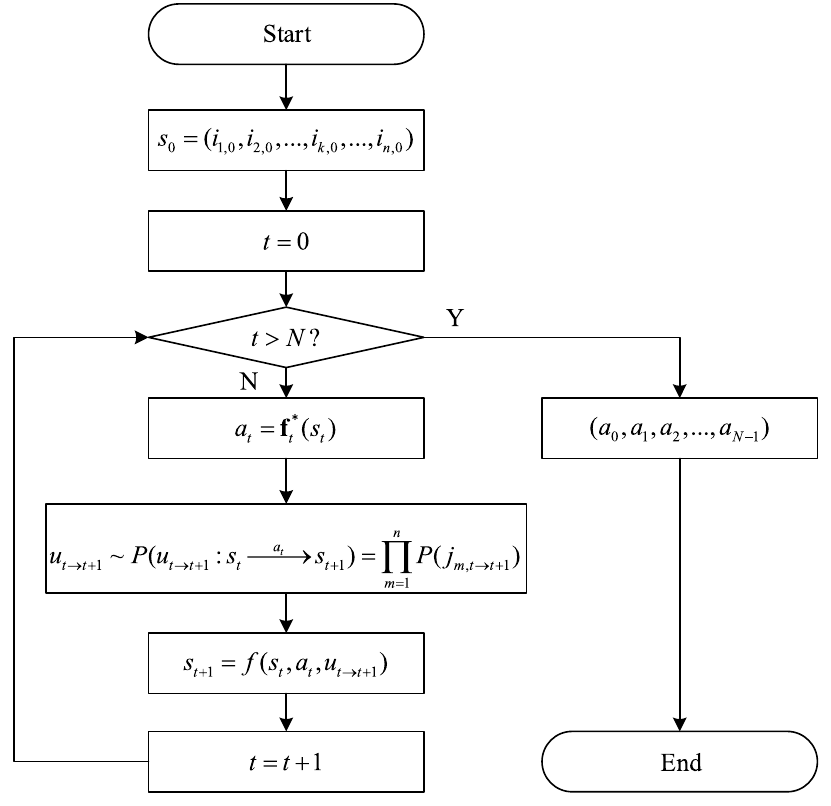
Figure 4. The flow chart of generating fixation